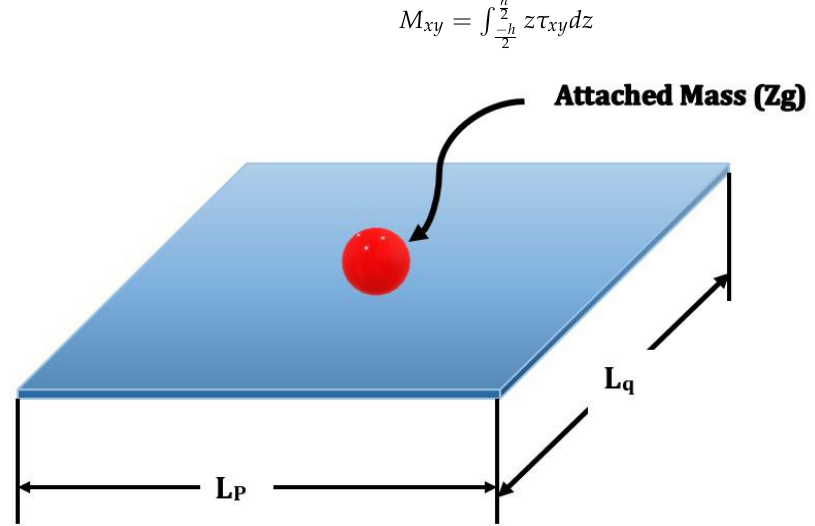
Figure 3. A single-walled GS with an attached mass is shown in a schematic diagram. The x- and y-axes are aligned with the SLG ’s length Lp and width Lq, respectively, and the z-axis is aligned with the SLG ’s thickness h [50].